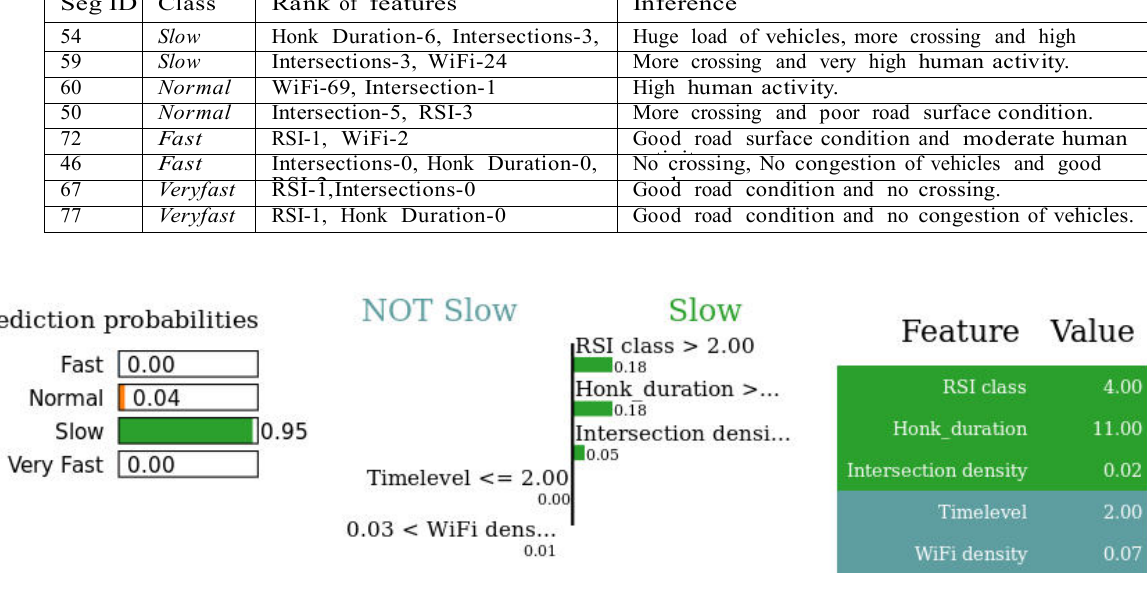
Figure 11. Feature Behaviour Analysis using